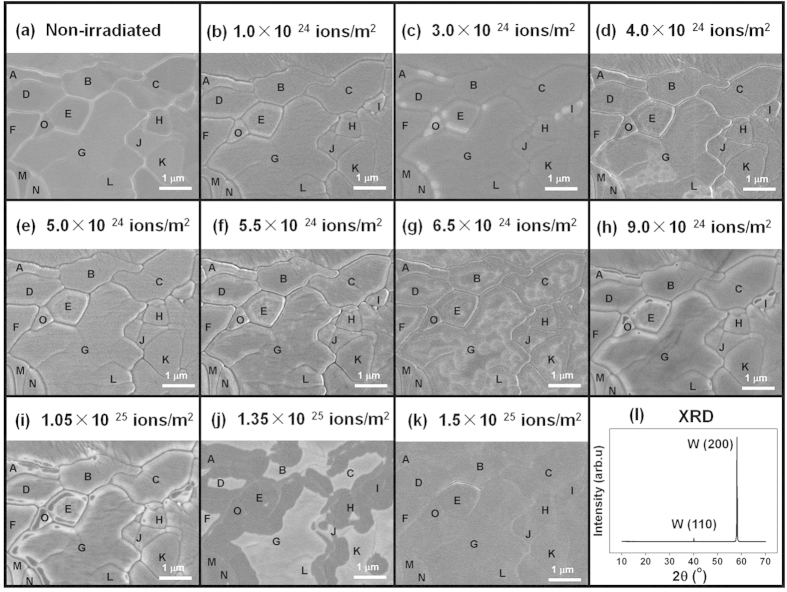
SEM observation for the W (100) crystal prior to H irradiation (a) and irradiated with 120 eV hydrogen ions at fluences of 1.0 × 1024–1.5 × 1025/m2 (b–k), and its XRD spectrum (l).